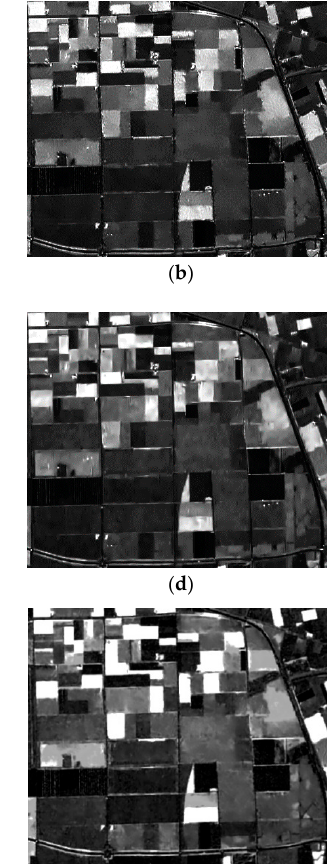
12 of 18 Figure 8. Filtered images for the Highway image contaminated by four-look speckle. ( a ) Original image. ( b ) Speckled image. ( c ) PPB [13]. ( d ) SAR-BM3D [14]. ( e ) SAR-POTDF [16]. ( f ) SAR-CNN [28]. ( g ) SAR-DRN. 4.3. Real-Data Experiments As shown in Figures 9–11, we also compared the proposed method with the four state-of-the-art methods described above for three real SAR images. These three SAR images are all acquired by the Airborne Synthetic Aperture Radar (AIRSAR), which are all four-look data. In Figure 9, it can be clearly seen that the result of SAR-BM3D still contains a great deal of residual speckle noise, while the results of PPB, SAR-POTDF, SAR-CNN, and the proposed SAR-DRN method reveal a good speckle-reduction ability. PPB performs very well in speckle reduction, but it generates a few texture distortions in the edges of prominent objects. In homogeneous regions, SAR-POTDF does not perform as well in speckle reduction as the proposed SAR-DRN. As for SAR-CNN, its edge-preserving ability is weaker than that of SAR-DRN. Visually, SAR-DRN achieves the best performance in speckle reduction and local detail preservation, performing better than the other mainstream methods; in Figure 10, all the five methods can reduce the speckle noise well, but PPB obviously results in an over-smoothing phenomenon. Besides, in Figure 11, the result of SAR-CNN still contains some residual speckle noise. Simultaneously, PPB, SAR-BM3D, and SAR-POTDF also result in an over-smoothing phenomenon, to some degree, as shown in the marked regions with complex geometric features. It can be clearly seen that the proposed method has both a well speckled noise reduction ability and preserving detail ability for the edge and texture information.